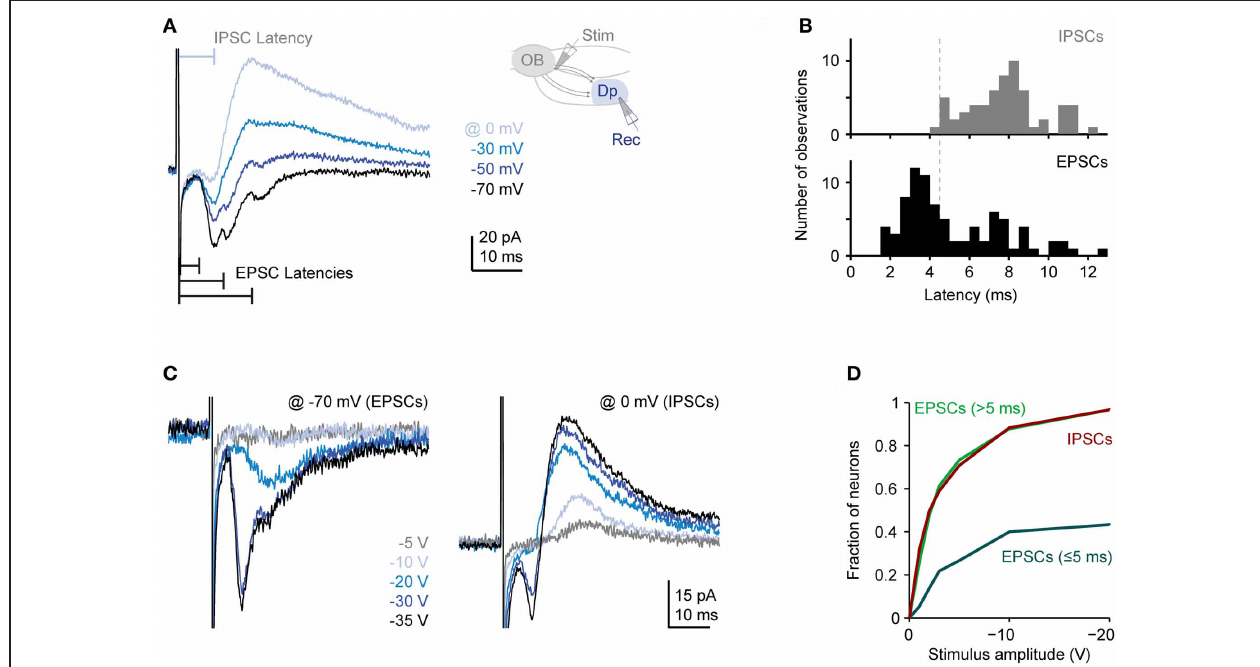
in 38 fish; the majority was vglut2a-GFP-positive). If a compound current response had multiple distinct components, only the shortest latency was counted. Stimulation amplitude was − 20 to − 30V. (C) Examples of EPSCs and IPSCs evoked by stimuli of different intensities. Note recruitment of additional response components with increasing stimulus amplitude. (D) Fraction of neurons showing a short-latency (presumably monosynaptic) EPSC, at least one long-latency (presumably polysynaptic) EPSC, and an IPSC as a function of stimulus amplitude ( n = 30 neurons). If a compound current response had multiple distinct components, all components were